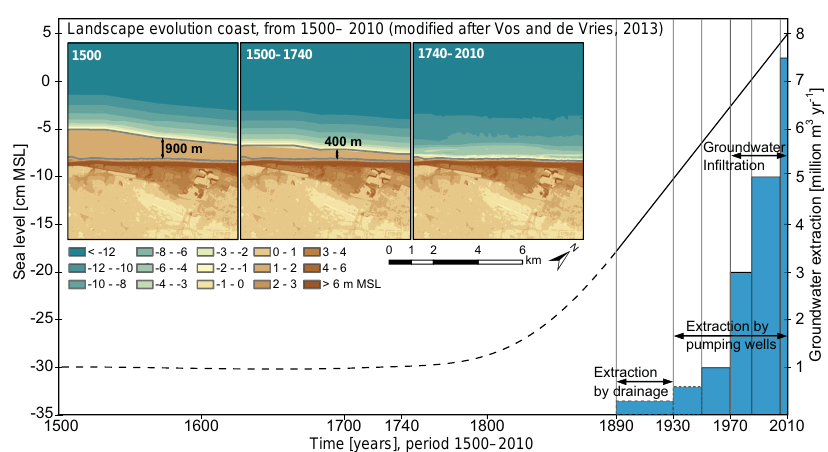
Figure 5. Simulation of historical coastal erosion (based on palaeogeographic maps of Vos and de Vries, 2013), sea-level rise (black line) and groundwater extraction (blue) in the period 1810–2010; dashed lines indicate estimates, and vertical grey lines refer to stress periods (CBS et al.,